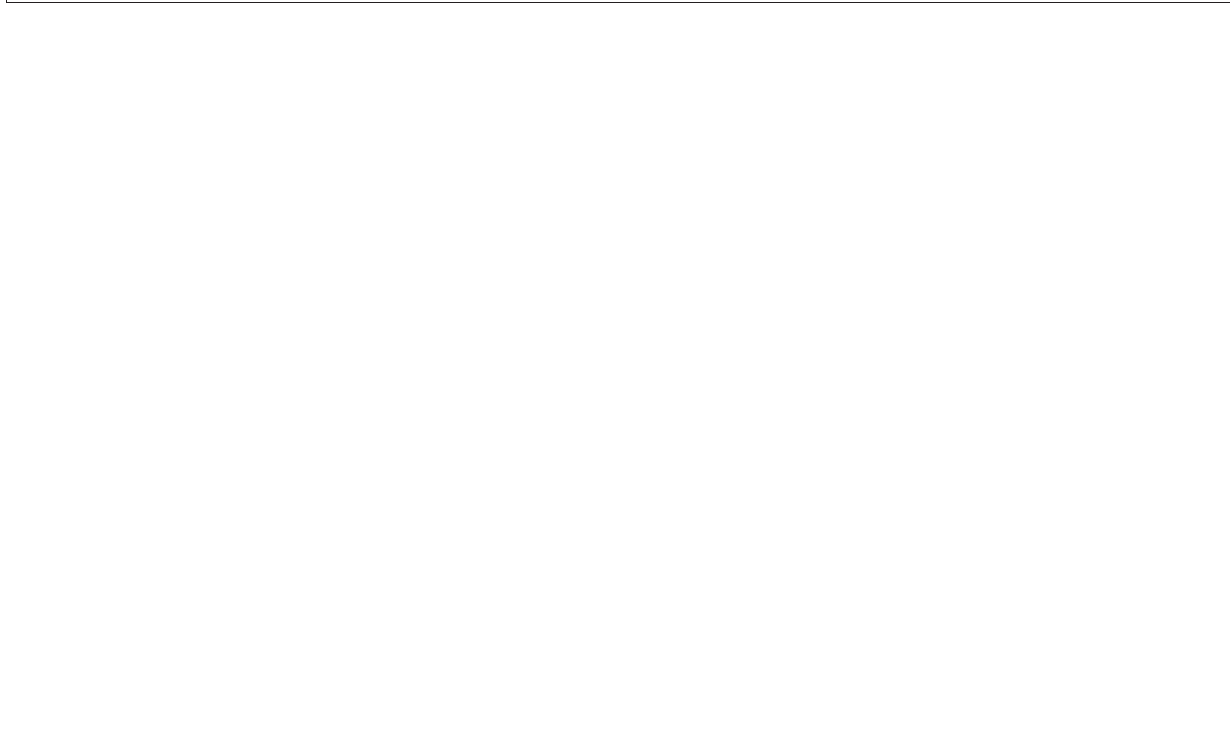
FIGURE 3 | Distribution of samples by tenotomy vs sham and DE genes over each time point post-tenotomy. Venn diagram (A) highlights the DE genes at each time point and the overlap with other time points. The bar chart (B) displays the number of DE genes which are up or down regulated at each timepoint. Data in the heatmap (C) is presented as normalized expression for each tenotomy and sham sample at each time point post-tenotomy with a z-score scale by rows and an average hierarchical clustering by